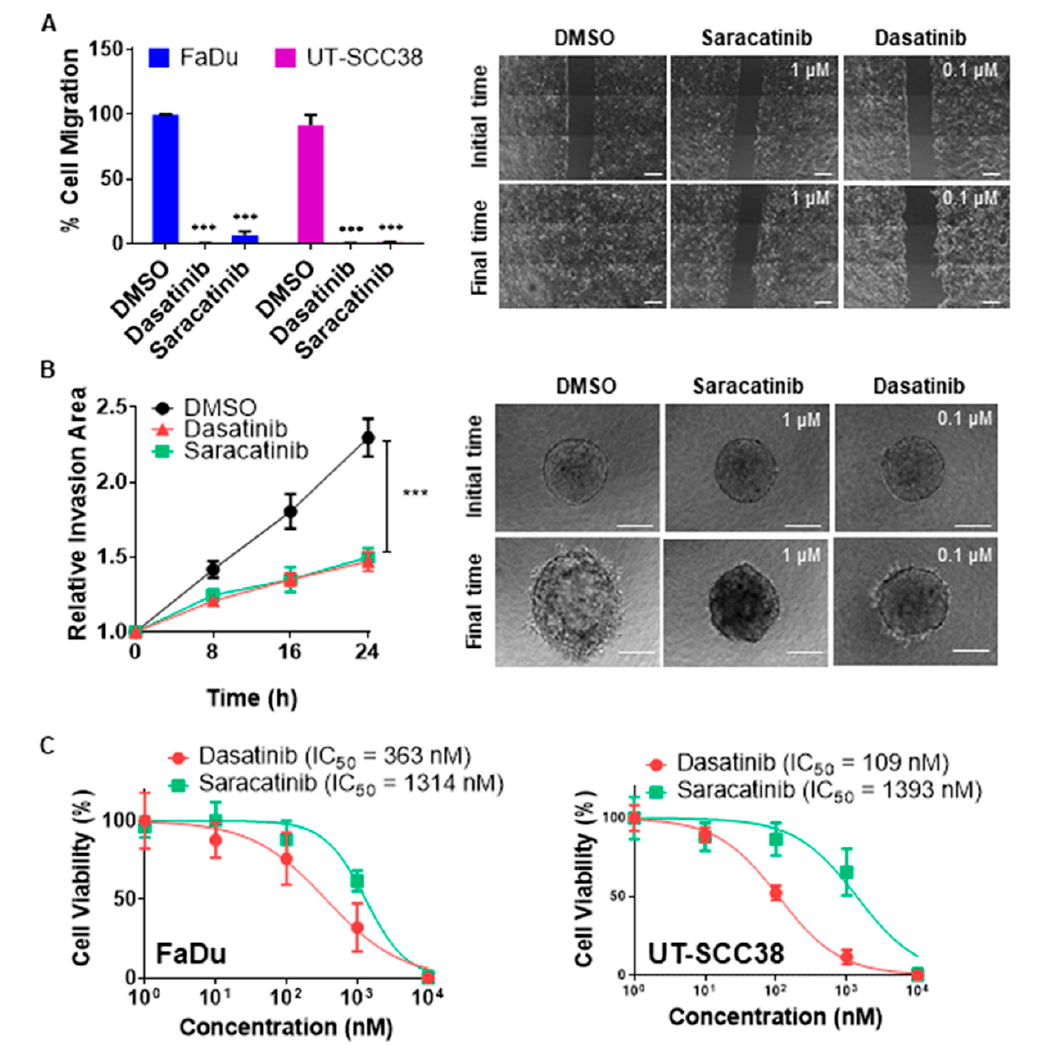
Figure 1. Effect of dasatinib and saracatinib on cell migration, invasion, and growth of head and neck squamous cell carcinomas (HNSCC)-derived cell lines. ( A ) Wound healing assays in FaDu and UT-SCC38 cells treated with either DMSO (vehicle), 0.1 µ M dasatinib, or 1 µ M saracatinib. The percentage of cell migration (left panel) and representative images showing the initial scratch (t = 0) area and the residual area at the final time (t = 15 h) in FaDu cells (right panel) are displayed. Scale bars = 200 µ m. Data are expressed relative to vehicle-treated cells (mean ± SD, Student’s t -test, *** p < 0.001). ( B ) 3D spheroid invasion assays in FaDu cells treated for 24 h with either DMSO (vehicle), 0.1 µ M dasatinib, or 1 µ M saracatinib. The quantification of the invasive area at the indicated times (left panel) and representative images of FaDu spheroids at initial (t = 0) and final time (t = 24 h) (right panel) for the different treatments are displayed. Scale bars = 200 μ m. Data are expressed relative to DMSO-treated cells (mean ± SD, Student’s t -test, *** p < 0.001). ( C ) Cell viability of FaDu (left panel) and UT-SCC38 (right panel) cells was measured by MTS assay after 72 h treatment with increasing doses of either dasatinib or saracatinib. IC 50 values are shown.